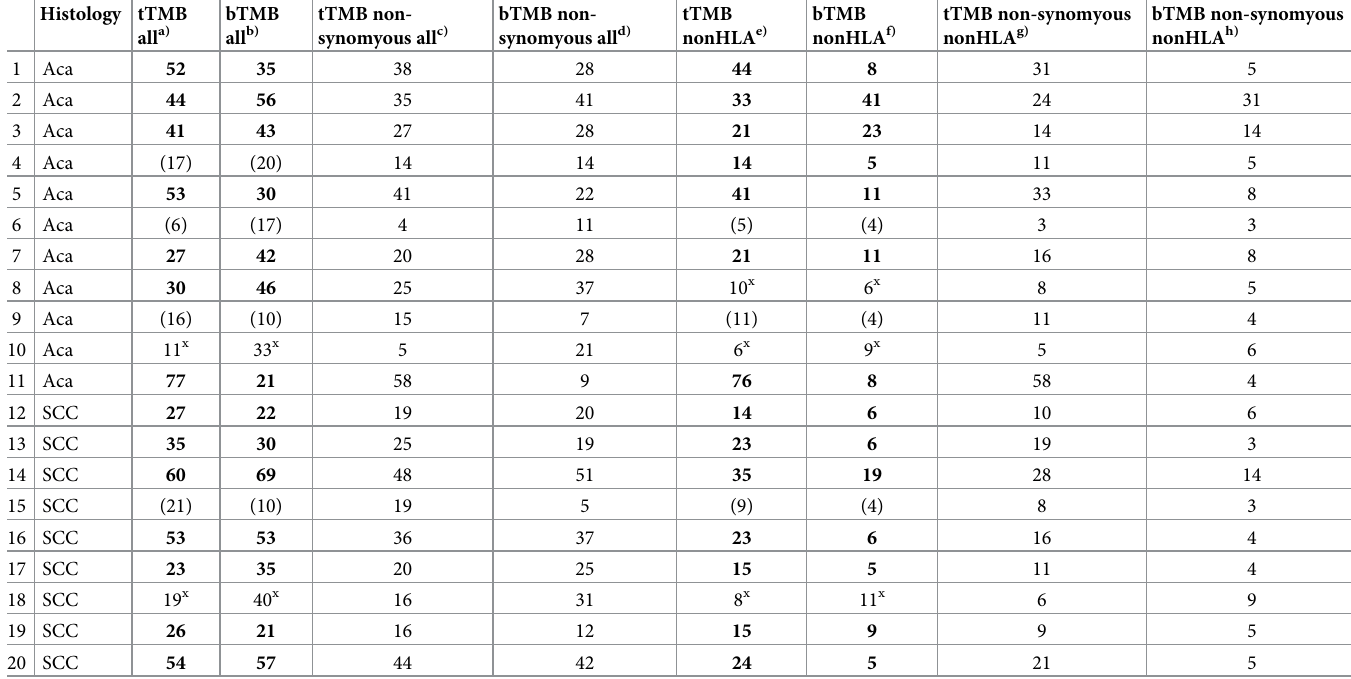
Table 3. Results of tTMB and bTMB using different approach of TMB calculation and our gene panel LMB_TMB1. Histology tTMB all